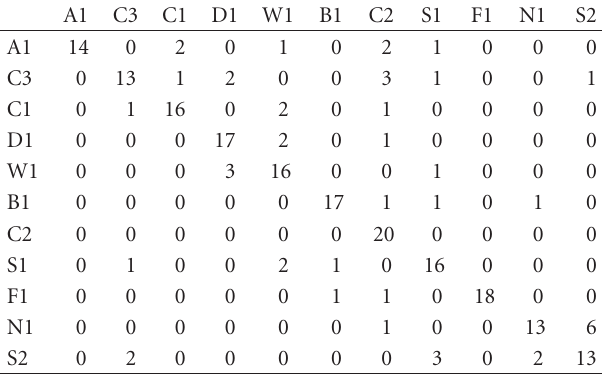
Table 3: Class-confusion matrix for the nearest-neighbor classifi- cation